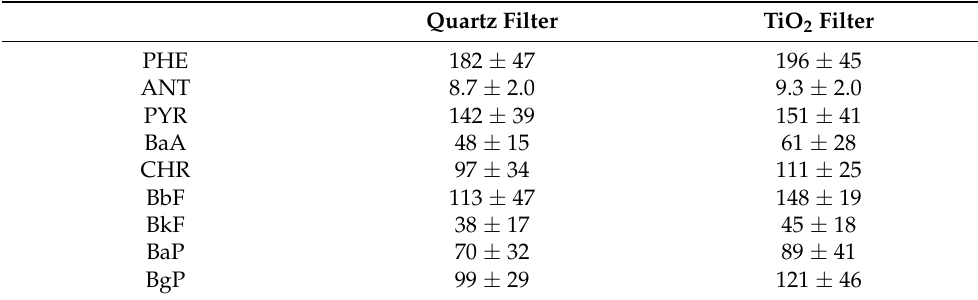
Table 1. Amounts of nine PAHs collected on quartz filters and TiO 2 filters (ng/filter) before UV-irradiation.